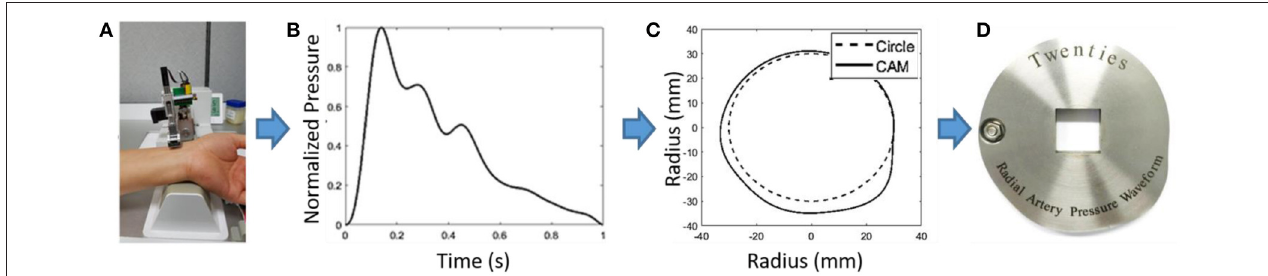
FIGURE 1 | (A) In vivo data collection using robotic tonometry system to get an example pulse waveform, (B) Normalized blood pressure of waveform vs. time, (C) Conversion of waveform into a radial geometry, (D) Manufactured cam disk from radial waveform (Yang et al., 2019).